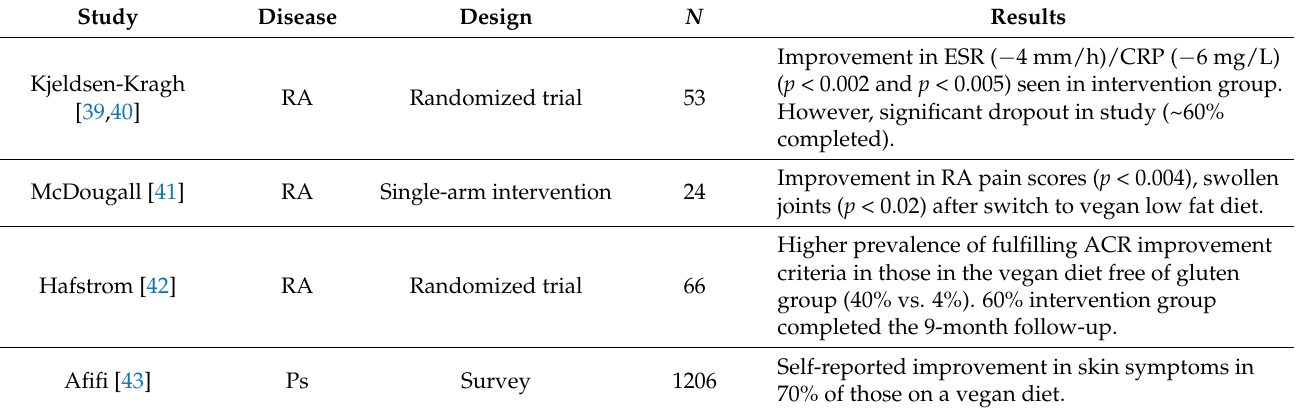
Table 2. Summary of vegetarian/vegan and gluten-free diet studies in rheumatoid arthritis and psoriasis with potential applicability to